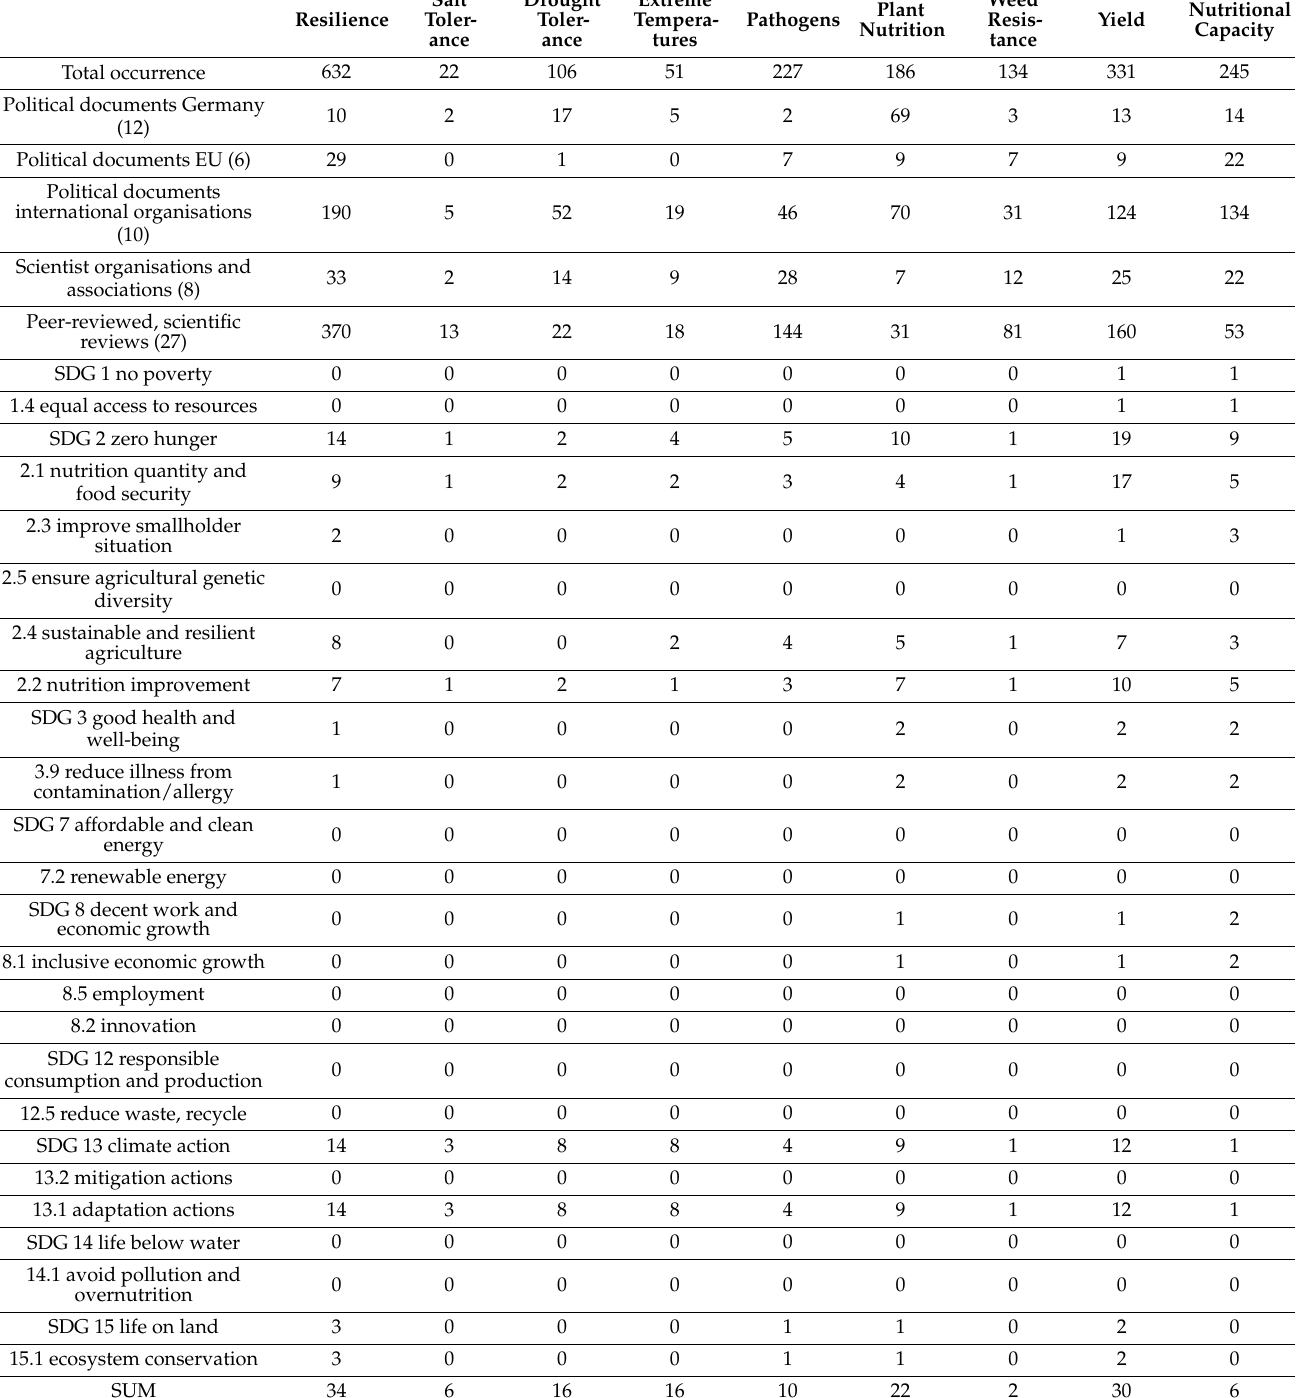
Table 1. Numbers of plant trait codings in analysed documents and co-occurrence with SDG